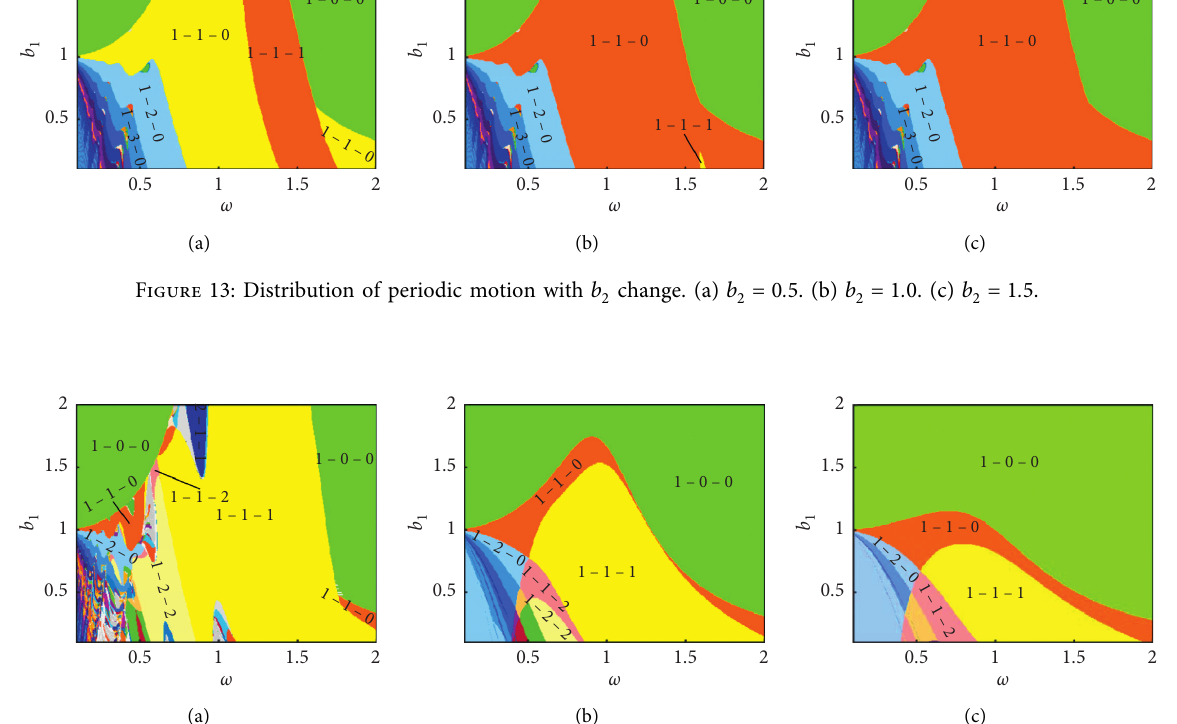
Figure 13: Distribution of periodic motion with b